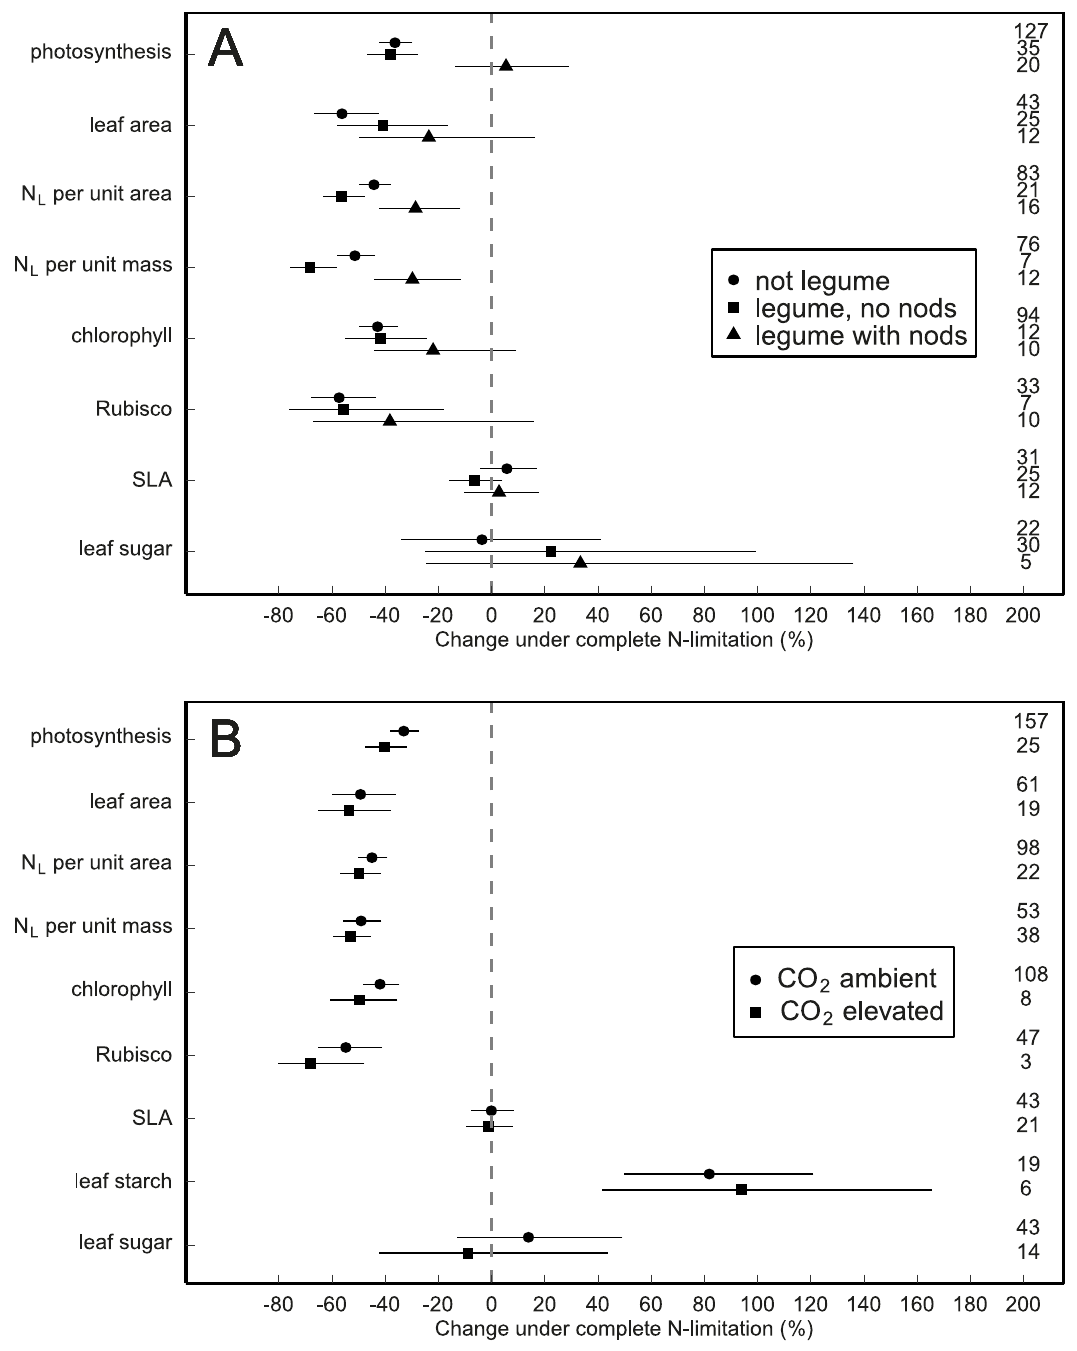
Fig 4. N limitation response of different legume status and CO 2 experimental levels. N limitation response of crops (model estimate and 95% CI) with different legume status (panel a), and at different [CO2] levels (panel b). The factors of the variable legume status (panel a) are not legume , legume , no nodules and legume , with nodules . Numbers on the right in each panel indicate the number of experiments in each group. Leaf starch is not included in panel (a) as there are no studies with nodulating legumes.